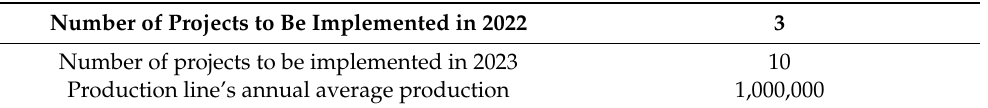
Table 3. Data used to calculate the saving achieved for new projects until 2026. Number of Projects to Be Implemented in 2022 3 Number of projects to be implemented in